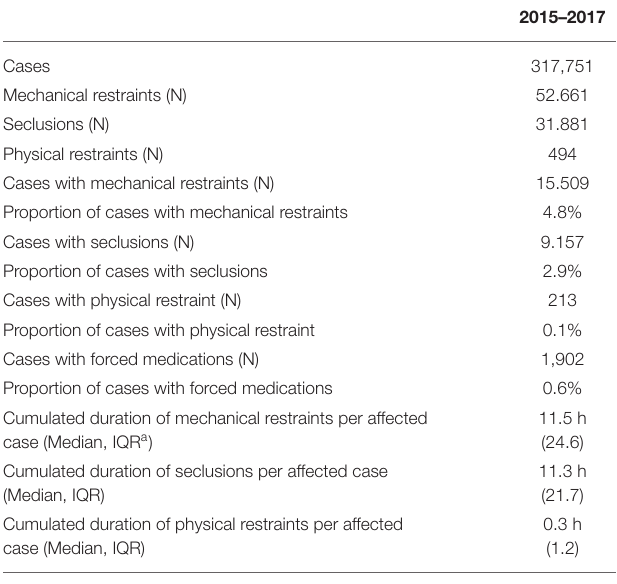
TABLE 1 | Cases with coercive measures.